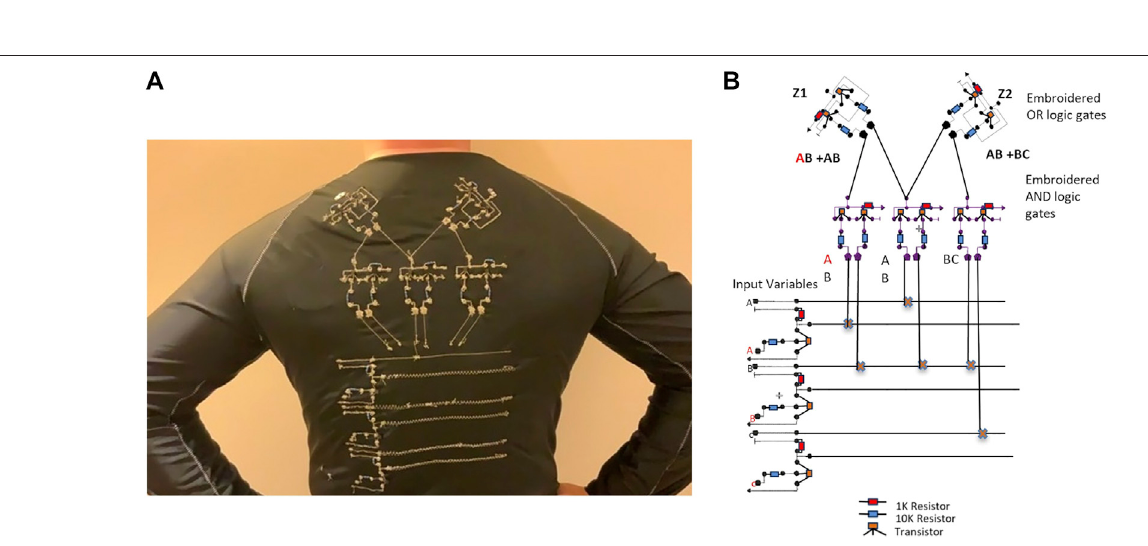
Frontiers in Communications and Networks |